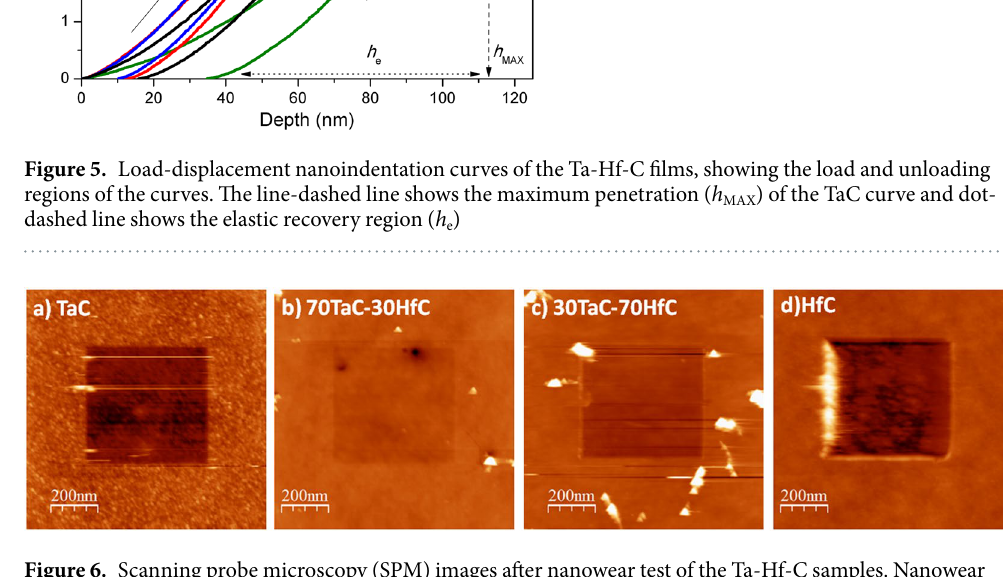
Figure 6. Scanning probe microscopy (SPM) images after nanowear test of the Ta-Hf-C samples. Nanowear tests were performed over an area of 1 µ m × 1 µ m at a constant load of 0.1 mN and a frequency of 2 Hz (20 µ